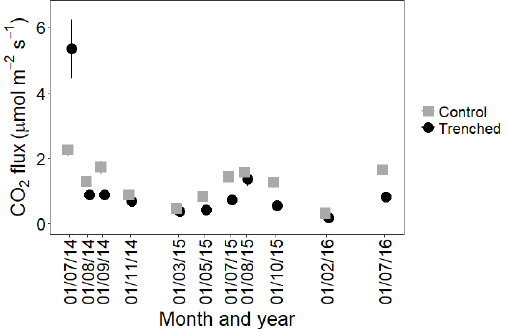
Figure 3. Mean CO 2 fluxes from control (grey squares) and trenched (black circles) plots over time, averaging across all micro- forms ( n = 12) and both litter treatments. Error bars are standard errors and are in most instances smaller than symbols.